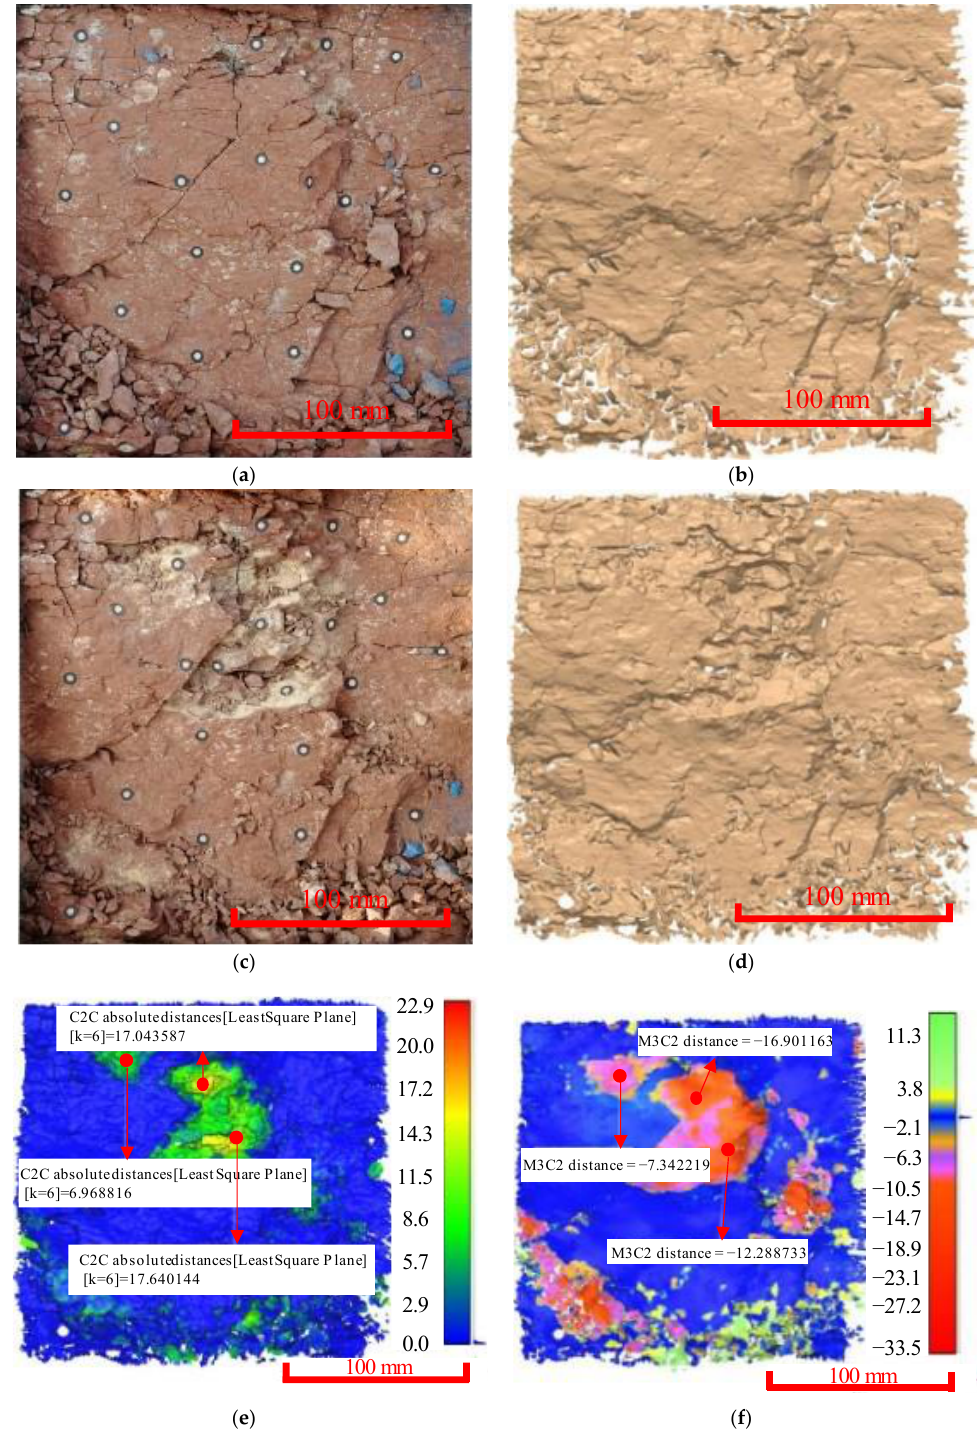
Figure 7. In situ and 3D cloud diagram of the weathered area. ( a ) Site picture of the measuring area (Period I). ( b ) Image of the 3D laser scanning (Period I). ( c ) Site picture of the measuring area (Period II). ( d ) Image of the 3D laser scanning (Period II). ( e ) Deformation distribution obtained using the C2C method. ( f ) Deformation distribution obtained using the M3C2 method.